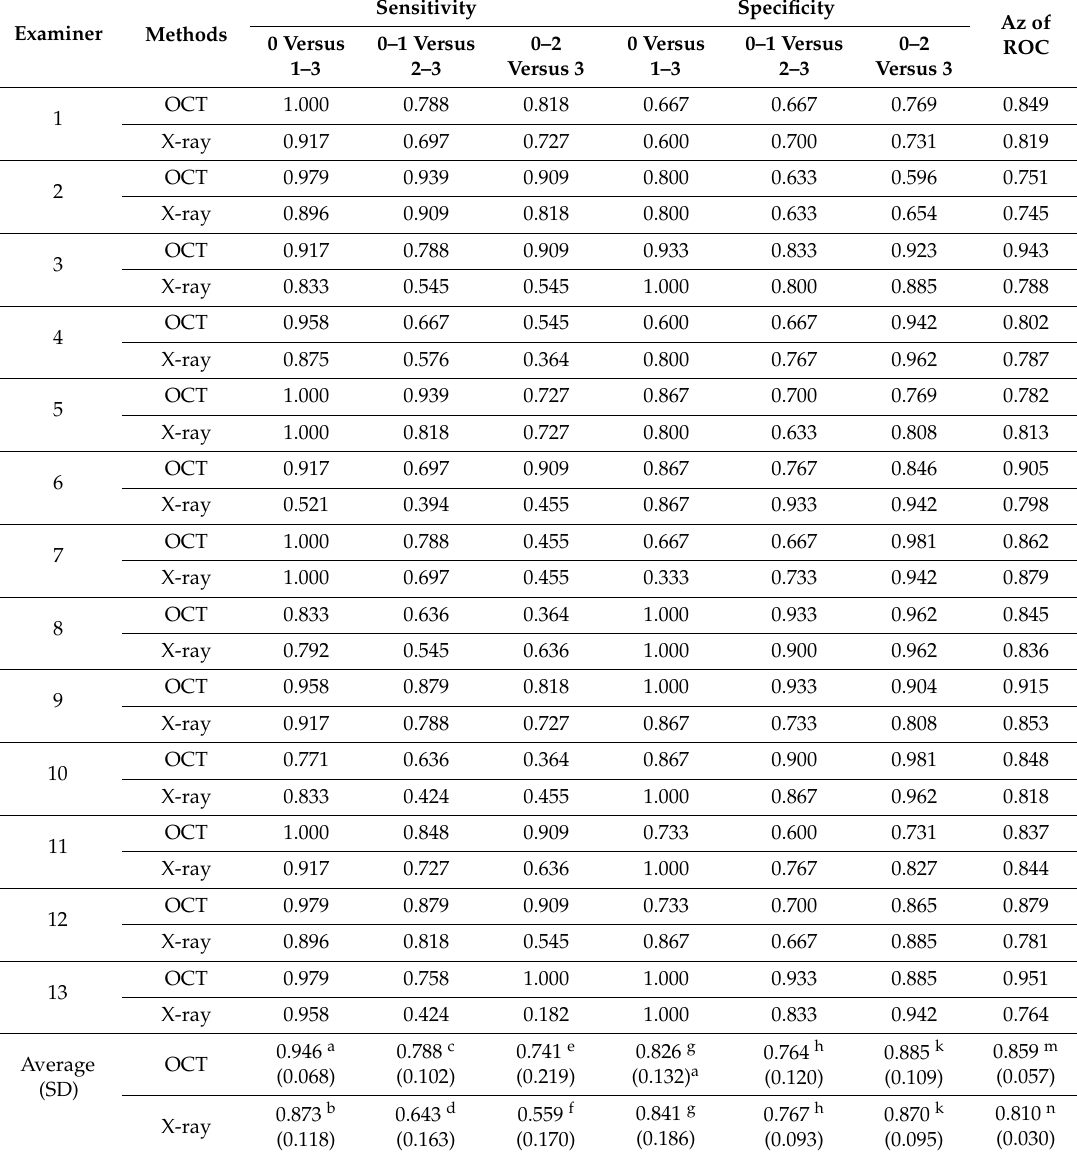
Table 1. Cuto ff values: a significant di ff erence was observed in sensitivity and Az value receiver operating characteristic (ROC) curve between OCT and radiography ( p < 0.05), whereas no such di ff erence in specificity was shown. Di ff erent superscripts letters indicated significant di ff